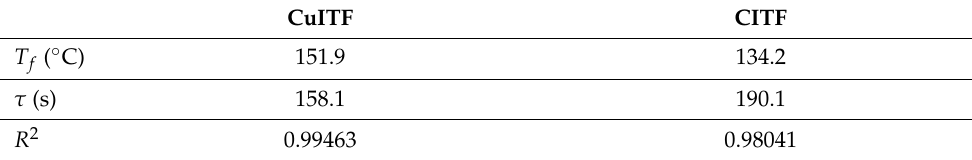
Table 1. Fitting modeling parameters for the heating curve of the CuITF and CITF. CuITF CITF T f ( ◦